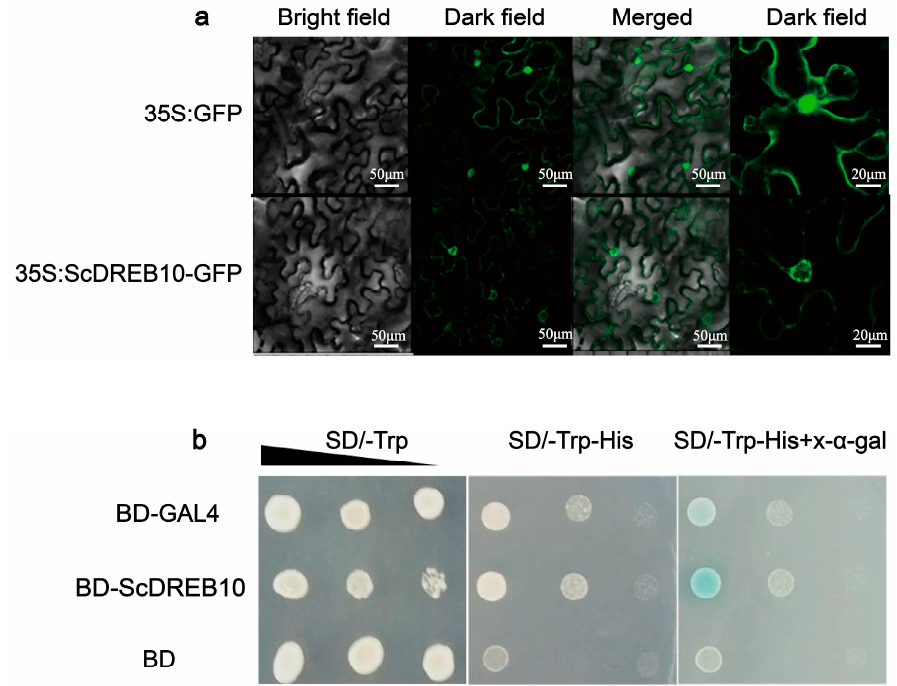
Figure 2. Analysis of subcellular localization and trans-activation activity of ScDREB10. ( a ) Subcellular localization of ScDREB10 in tobacco leaf epidermal cells. 35S:ScDREB10-GFP fusion protein and 35S:GFP control were transiently expressed in tobacco ( Nicotiana bentamiana .) leaf epidermal cells and transformed cells were observed with a laser scanning confocal microscope after incubation for 24 h in the dark. The images were presented bright field, dark field, and merge of bright field and dark field. ( b ) Trans-activation activity of ScDREB10 in yeast. Yeast cells yeast two-hybrid (Y2H) expressing the fusion proteins were cultured and adjusted to an OD600 of 2.0, then series diluted and dropped with 2 µ L on nutritional selective medium without tryptophan (SD/ − Trp), without tryptophan and histidine (SD/ − Trp − His), and SD/ − Trp − His with 5-Bromo-4-chloro-3-indolyl α - D -galactopyranoside (SD/ − Trp − His+x- α -gal). Photos were taken after incubating at 30 ◦ C for 2 to 4 days. Yeast cells expressing the empty vector pGBKT7-BD were used as negative control, and BD-GAL4 were used as positive control. SD: synthetic